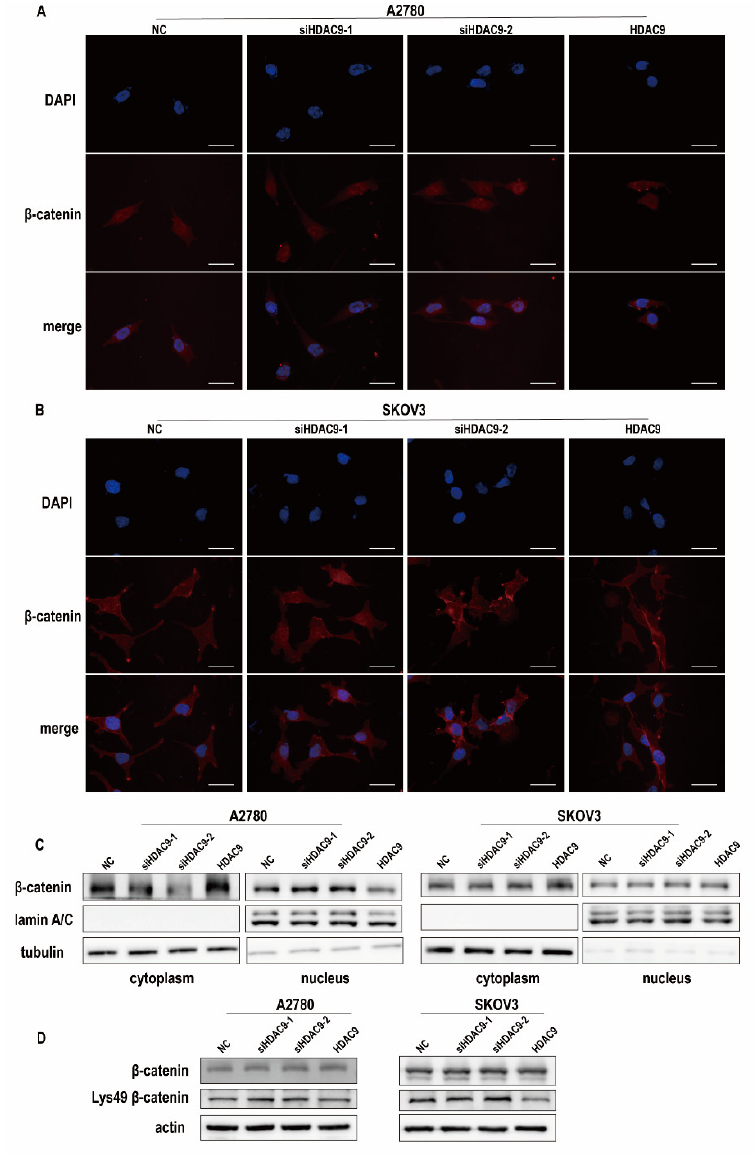
Figure 6. HDAC9 may inhibit EMT in A2780 cells by suppressing β -catenin signaling. A2780 and SKOV3 cells were transfected with a HDAC9 overexpression construct, HDAC9-shRNA plasmids (siHDAC9-1/2), or empty vector for 24 h. ( A , B ) Immunofluorescence staining for β -catenin in A2780 and SKOV3 cells (bar = 30 um). ( C ) Nucleus of A2780 and SKOV3 cells were isolated and the expression of β -catenin was investigated. ( D ) The expression of β -catenin and ac- β -catenin (Lys-49) in A2780 and SKOV3 cells was measured by Western blot.